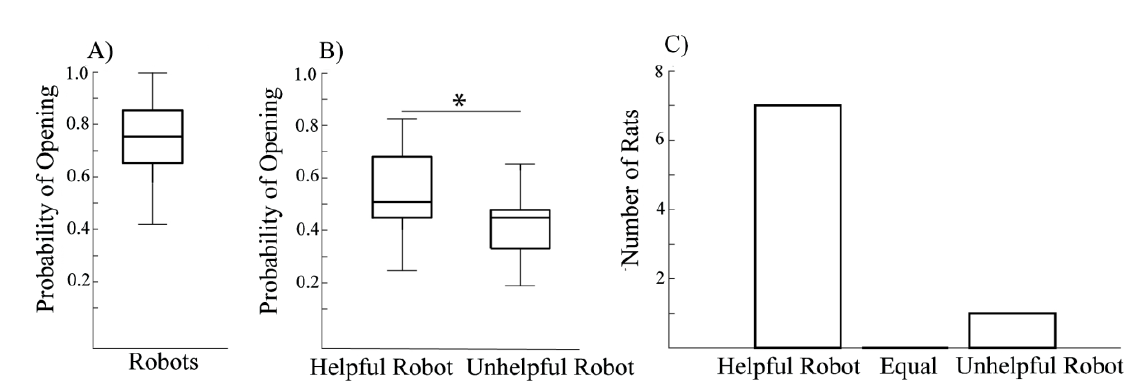
Figure 2 . A ) Rats frequently open for robots who are trapped in an enclosure. Center line = median. Top = 75 th percentile, bottom = 25 th percentile B ) Rats often open doors for both the helpful and unhelpful robot. However, they exhibited a preference for opening doors for the helpful robot. Center line = median. Top = 75 th percentile, bottom = 25 th percentile * p < .05 C ) Seven out of eight rats opened more frequently for the helpful